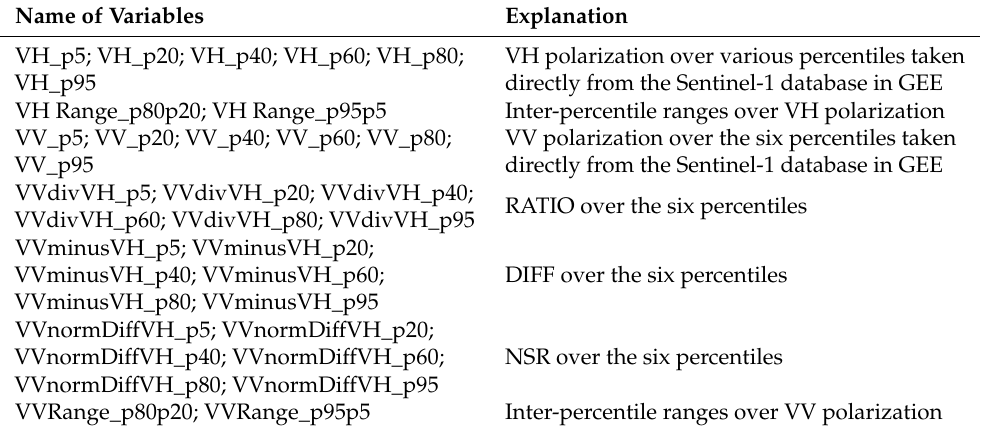
Table 2. The 34 variables used to analyze SAR